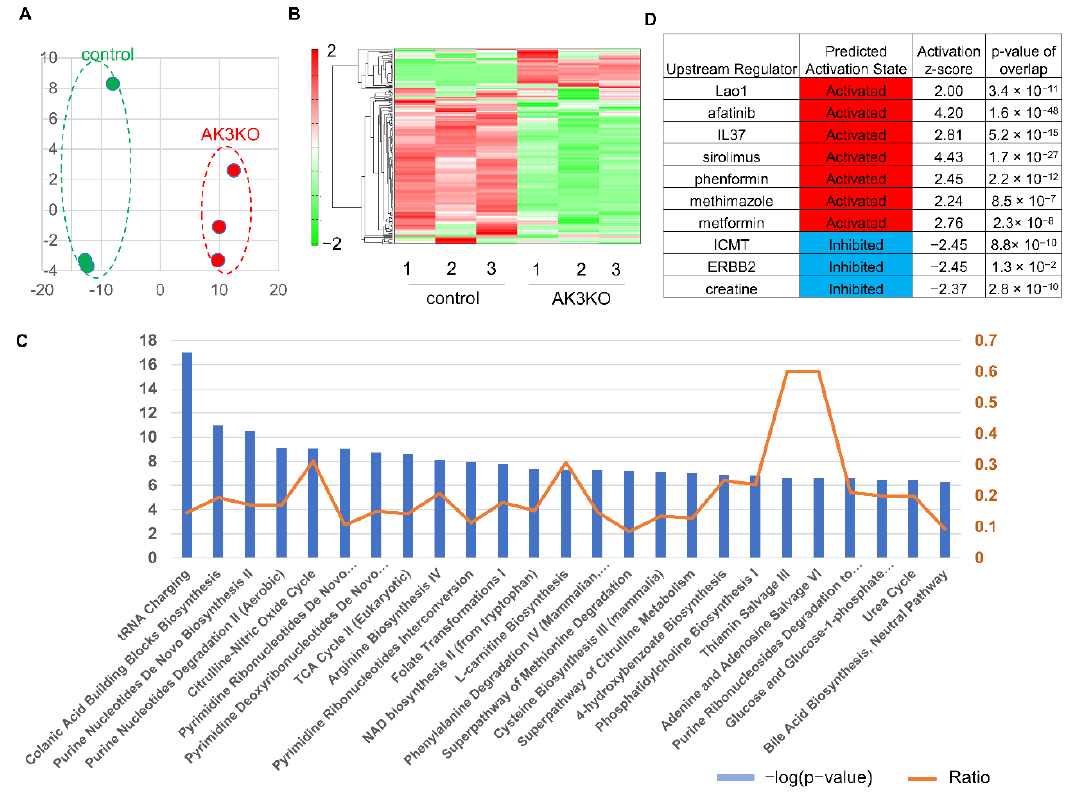
Figure 2. Comprehensive analysis using ingenuity pathways analysis (IPA). ( A ) Principal component analysis (PCA) of normalized metabolic data. Percentage values on axes represent contribution rate of first and second principal components (PC1 and PC2, respectively) to total variation. ( B ) Heat map of hierarchical cluster analysis. Columns indicate WT and AK3KO groups. Rows indicate normalized levels of each metabolite. Dendrogram of each heat map shows relationship to normalized metabolite level patterns. ( C ) Ranking of known pathways using IPA; p -values calculated using IPA software are displayed as inverse values. Orange line indicates proportion of genes included in each pathway. ( D ) Upstream regulators identified using IPA; expected activators and inhibitors are shown in red and blue, respectively.